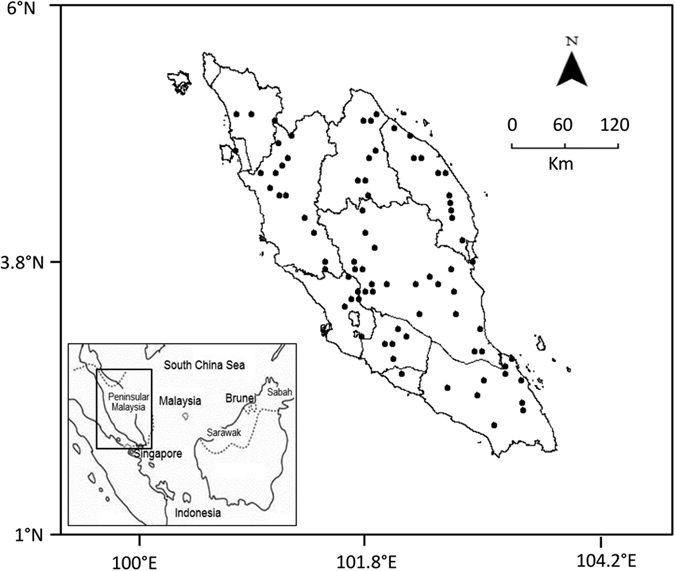
General flowering (GF) observation points in Peninsular Malaysia.The inset map shows the location of the study area in the broader region. All maps were developed using ArcGIS v.10 (www.esri.com) and combined using GIMP v.2.8.14 (www.gimp.org).